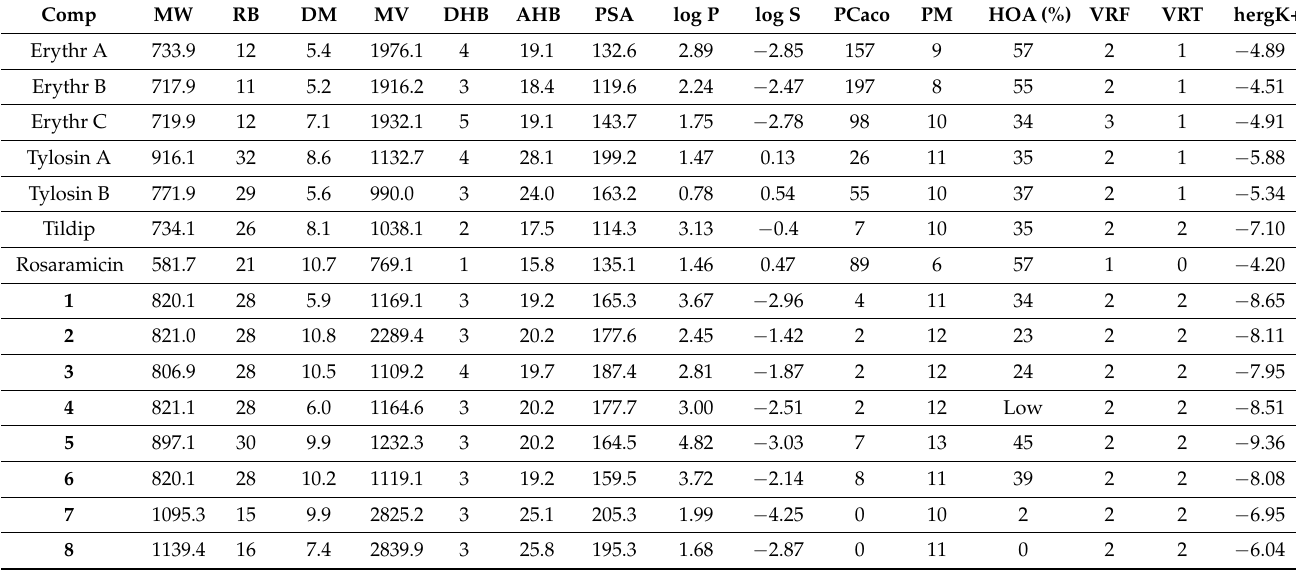
Table 4. Calculated absorption, distribution, metabolism, elimination, and toxicity (ADMET) parame- ters of the